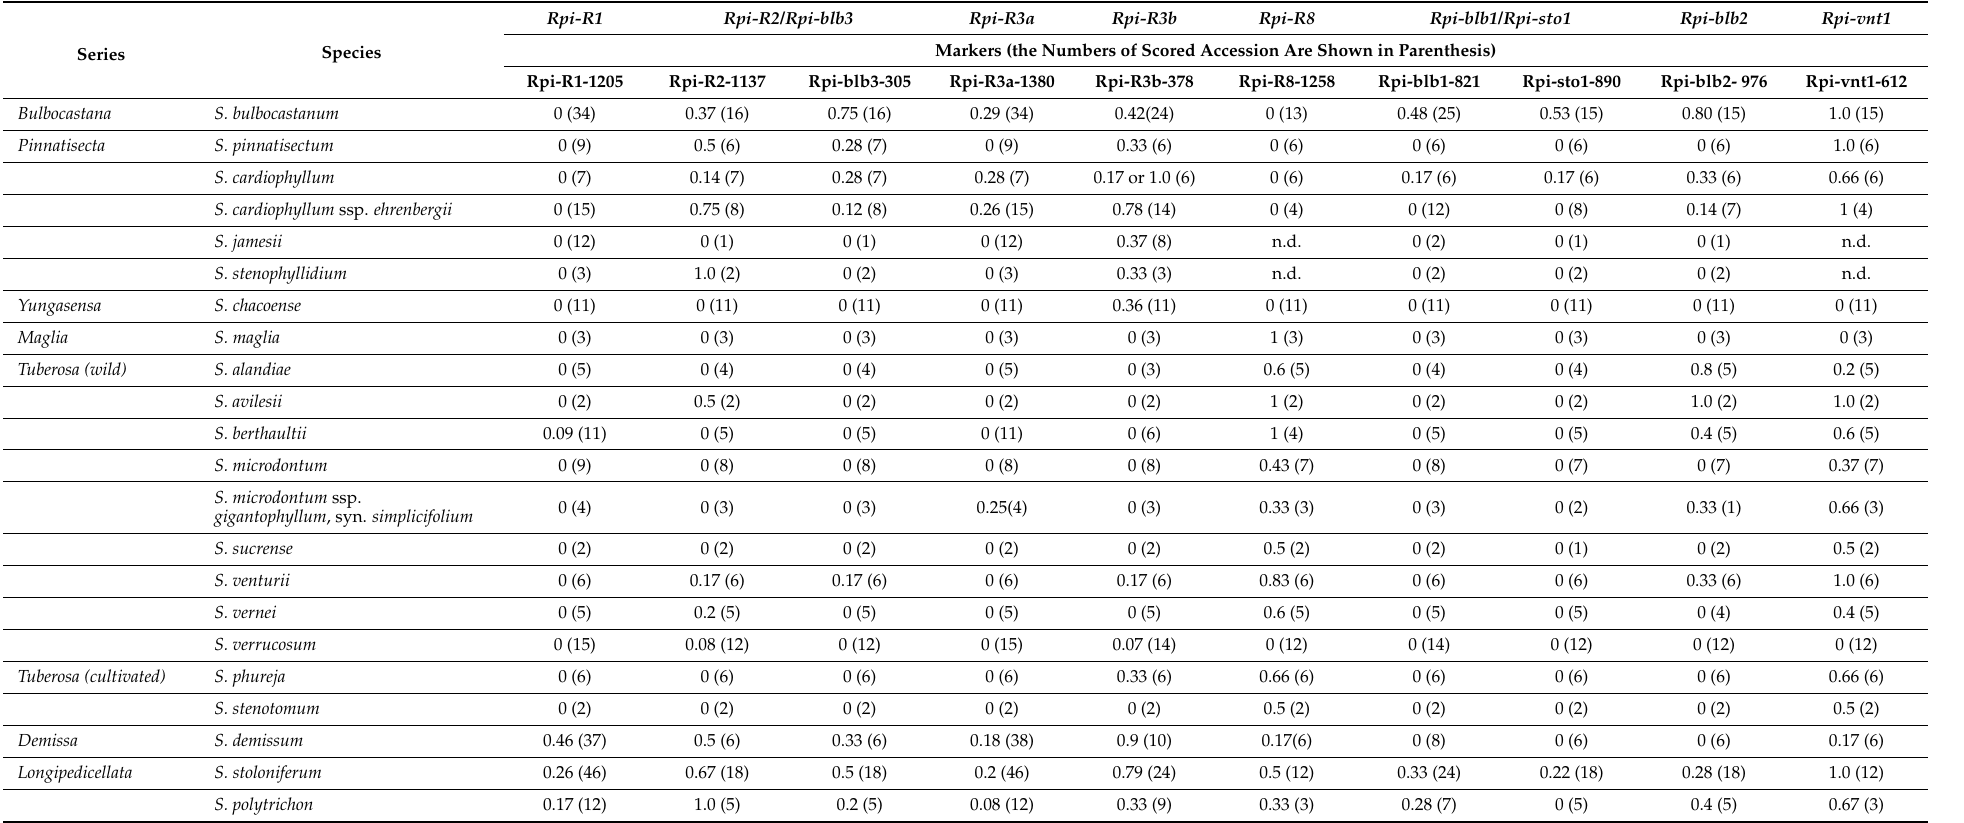
Table 2. Screening Solanum species with SCAR markers of the Rpi genes. Frequency of the markers (the number of accessions analyzed).